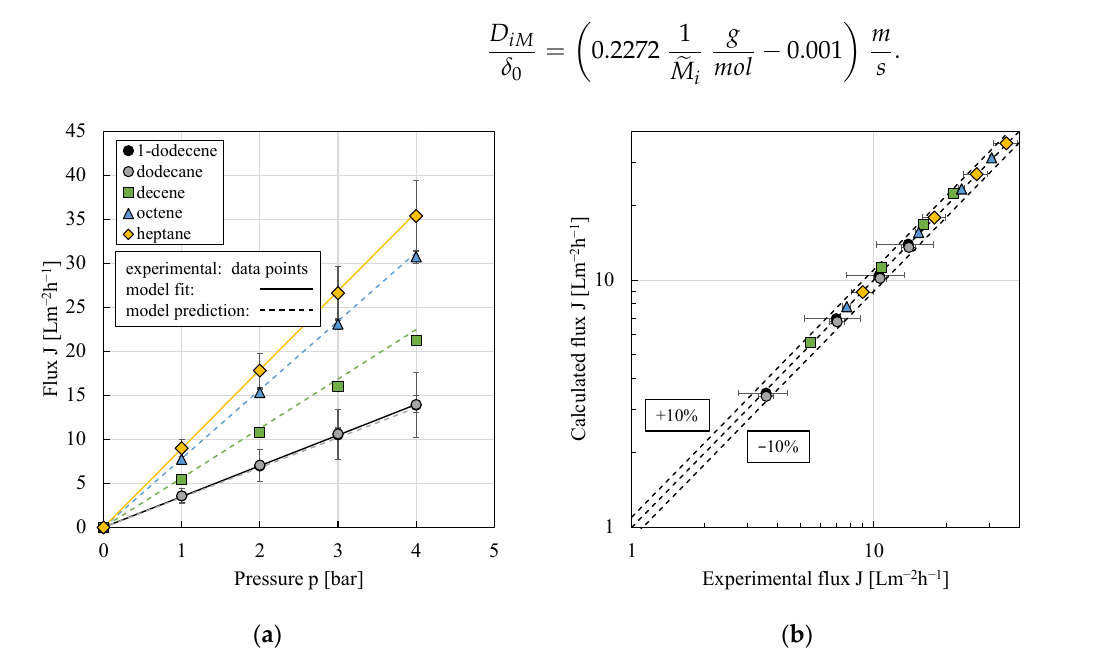
Figure 8. ( a ) Flux against pressure (for better graph clarity, only the results for decreasing pressures are shown) and ( b ) calculated flux vs. experimental flux using the solution–diffusion model and a linear correlation between the ratio of (diffusion coefficient/dry active membrane layer thickness) and the reciprocal of the molar mass of the organic solvent (Equations (3) and (6)). Experimental data points for 1-dodecene and dodecane overlap. For the model fit, the experimental data of 1-dodecene and heptane were used. All pressure stepping experiments were conducted at least in duplicate and mean values are shown. Error bars represent the standard deviation. Where not visible, error bars are smaller than the symbol